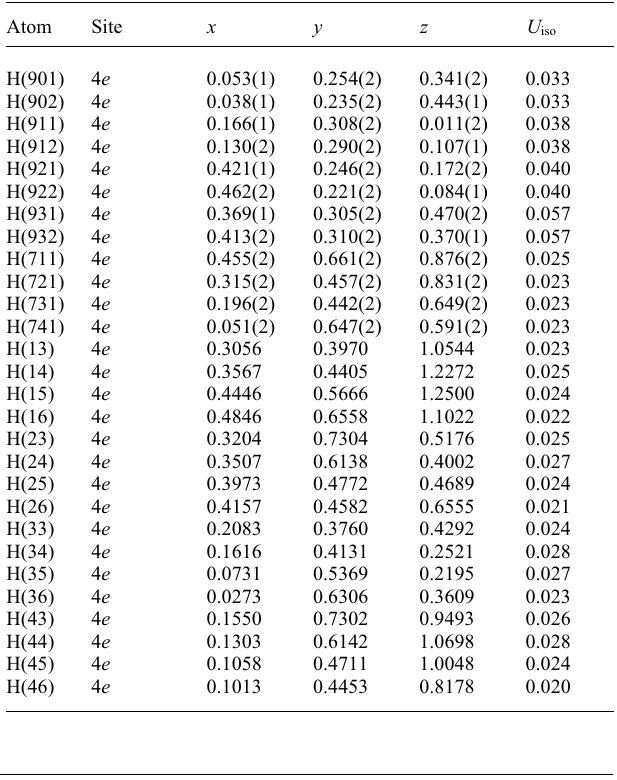
Table 2. Atomic coordinates and displacement parameters (in Å 2 ) .